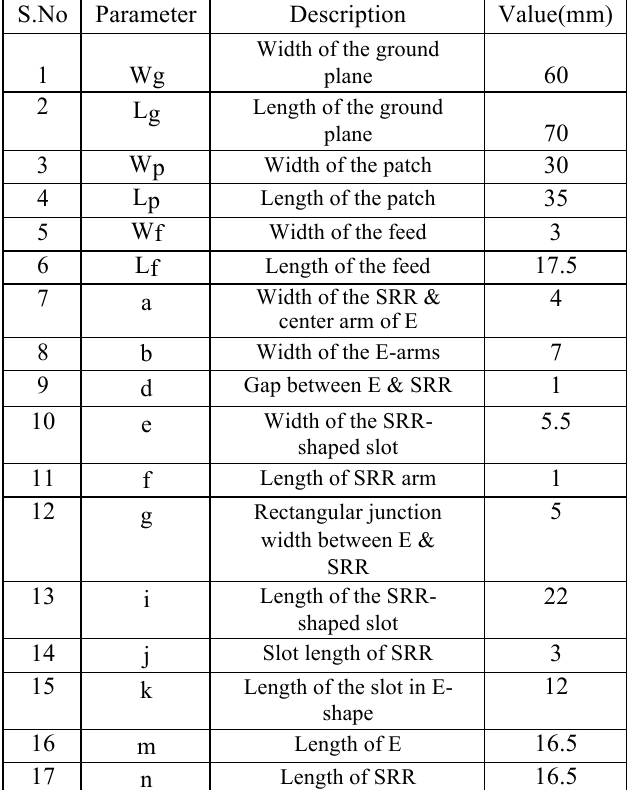
Table 1. Values of different parameters.